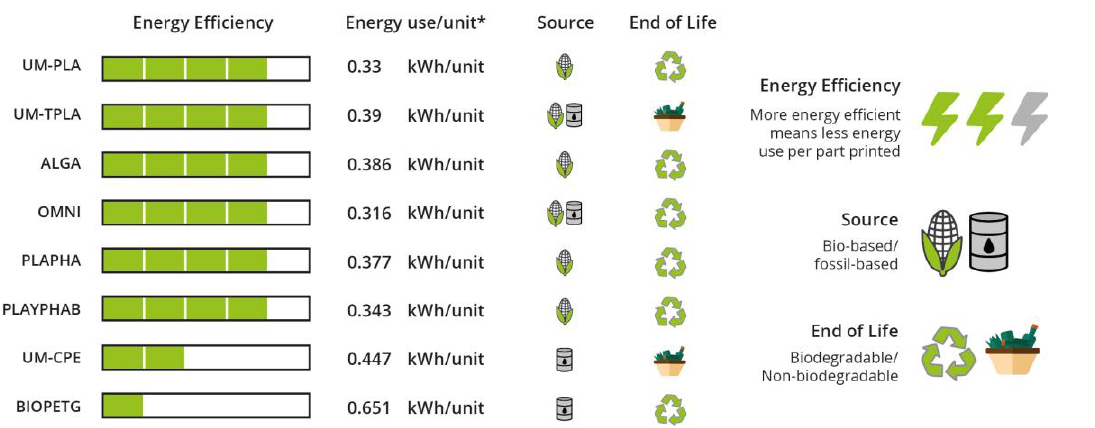
Figure 10. Material Guide for Green 3D printing: mechanical properties. Adapted from “3D Printing with Bioplastics”, 2020 [61]. Mechanical properties for materials PLAYPHAB and QMNI are estimated to be similar to PLAPHA and UM-TPLA respectively.